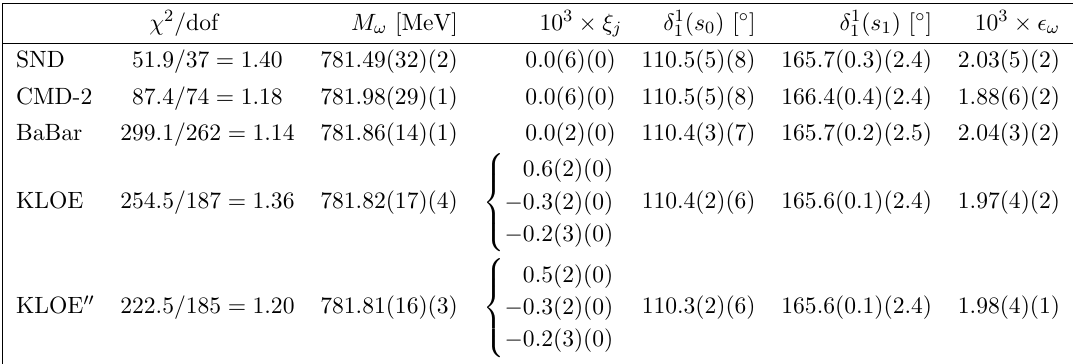
Table 9. Final (cid:12)ts to single e + e (cid:0) experiments with N (cid:0) 1 = 4 free parameters in the conformal polynomial. The (cid:12)rst error is the (cid:12)t uncertainty, in(cid:13)ated by combination of all systematic